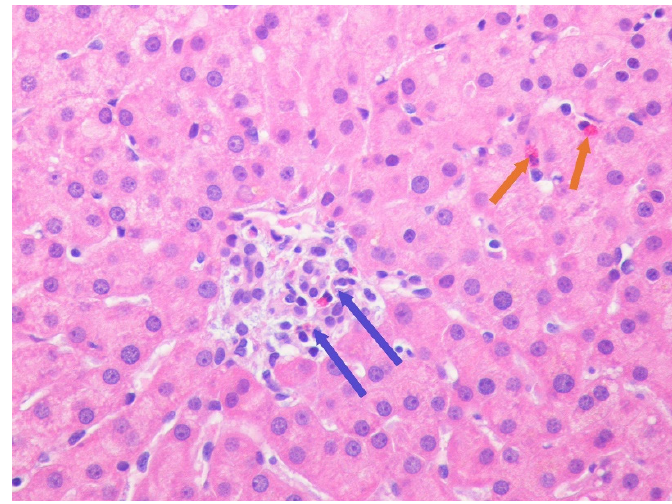
Figure 1. Lobular hepatitis with infiltration by lymphohistiocytic cells and eosinophilic cells, ceroid containing macrophages and mild hepatocellular swelling consistent with drug-induced liver injury. (H&E, magnification ×100, low power.)